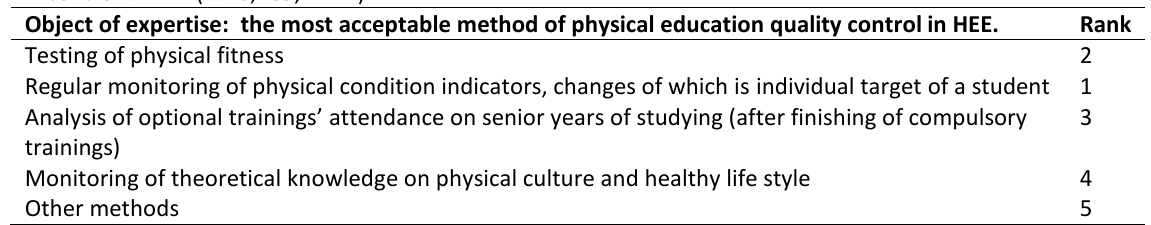
Table 2. Results of experts’ questioning about the most acceptable methods of physical education quality control in HEE (W=0,789,